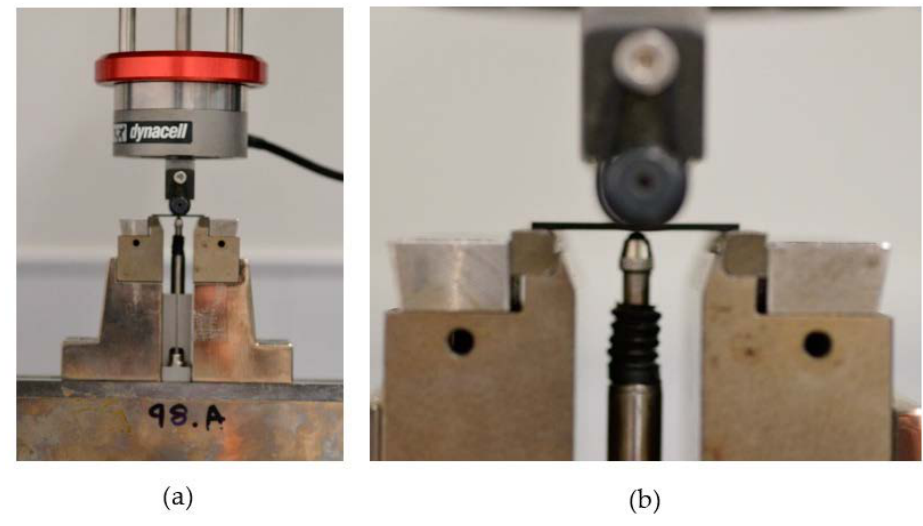
Figure 4. Test set-up for three-point bend testing in ( a ) test rig, and ( b ) showing linear variable differential transformer (LVDT).